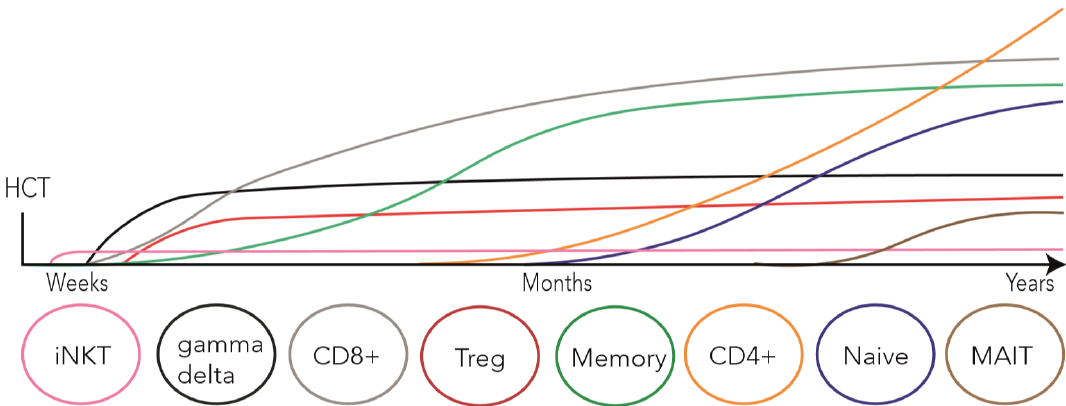
Figure 1. Schematic overview of the reconstitution of the distinct T cell subsets following allogeneic hematopoietic cell transplantation (HCT). iNKT, γδ T cells and Treg cells rapidly recover within weeks to normal levels after the time of Transplant. CD8 + , CD4 + and memory T cell recovery can be as early as one to two months, and these subsets subsequently reconstitute within one to two years. Reconstitution of the naive T cell pool highly depends on thymopoiesis and can take years, starting around three months after transplantation. MAIT cell frequencies seem to remain extremely low within the first year and only reach normal levels after years following allogeneic